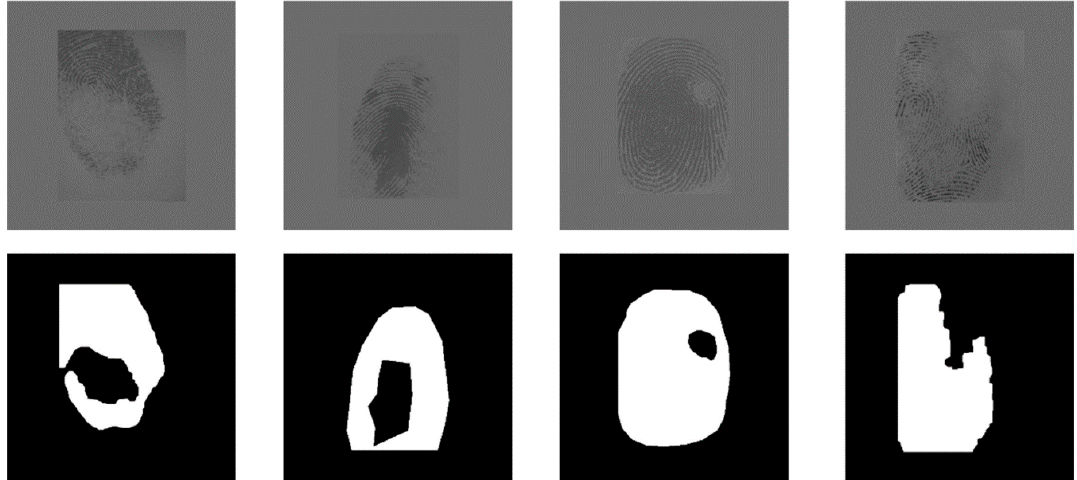
Figure 1. Original fingerprint and corresponding label.